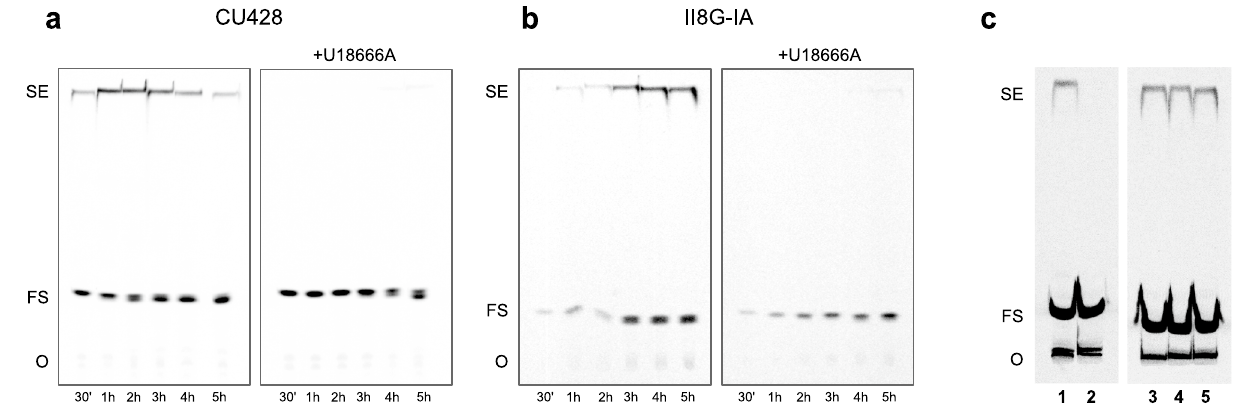
Figure 5. U18666A inhibits cholesterol esterification in T. thermophila without affecting ACAT. ( a , b ) Autoradiograms of TLC plates showing the sterol profile at different times after the addition of radiolabeled cholesterol in the presence or absence of U18666A in wild - type ( a ) and phagocytosis-deficient strains ( b ). Total lipids were extracted at various time points from cultures at exponential growth phase preincubated with 2 μM U18666A or vehicle for 15 min before the addition of 26 μM, 0.77 mCi/mol [ 14 C] − cholesterol. ( c ) Autoradiograms show radiolabeled steryl esters synthesized by ACAT activity in vitro . Cell-free extracts were prepared from wild - type cells incubated overnight in the presence of 26 µM cholesterol as indicated in Methods section. ACAT activity was determined by the addition of 260 µM, 0.5 mCi/mmol [ 14 C] − cholesterol and incubation for 1 h at 37 °C. The assays were performed in the absence (lanes 1 and 3 ) or presence of 20 µM U18666A (lane 4 ). In a parallel experiment, overnight cultures were treated for 20 min with 2 µM U18666A before preparation of extracts (lane 5 ). A supernatant incubated for only 30 s (lane 2 ) was used as negative control. Lipids were extracted and separated by TLC in silica gel plates. FS free sterols, SE steryl esters, O origin. Results shown are representative experiments repeated three times with similar